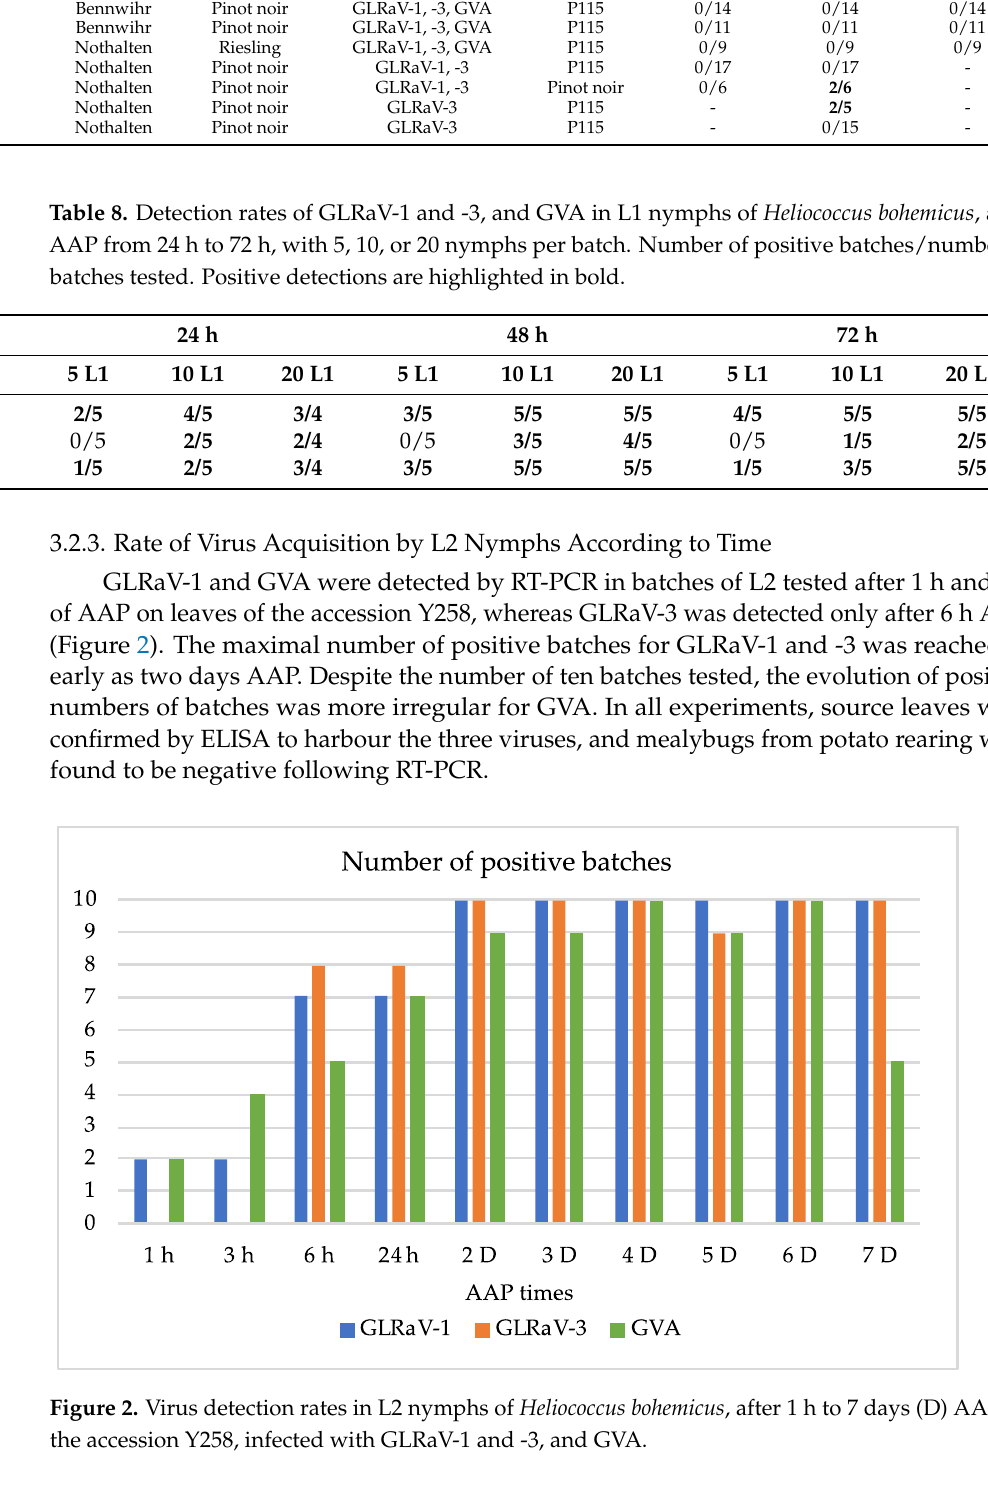
Figure 2. Virus detection rates in L2 nymphs of Heliococcus bohemicus , after 1 h to 7 days (D) AAP on the accession Y258, infected with GLRaV-1 and -3, and GVA.